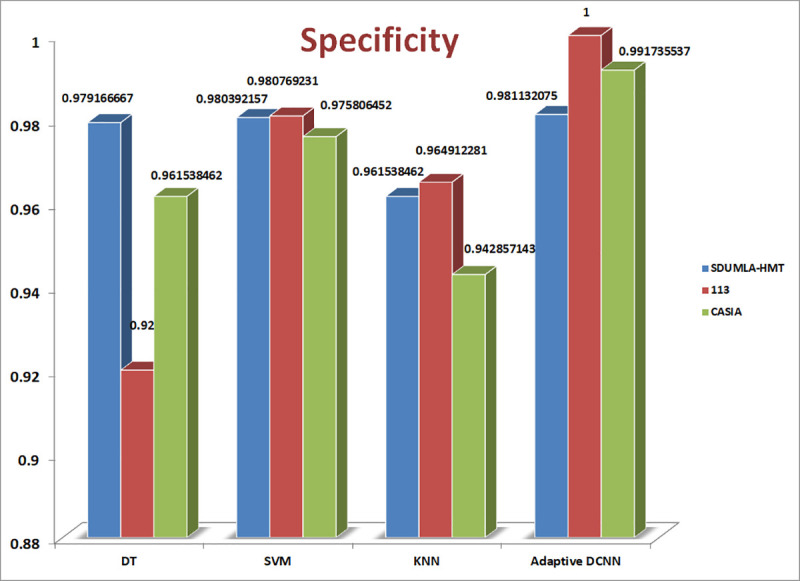
The specificity of the proposed system and the three comparison systems.